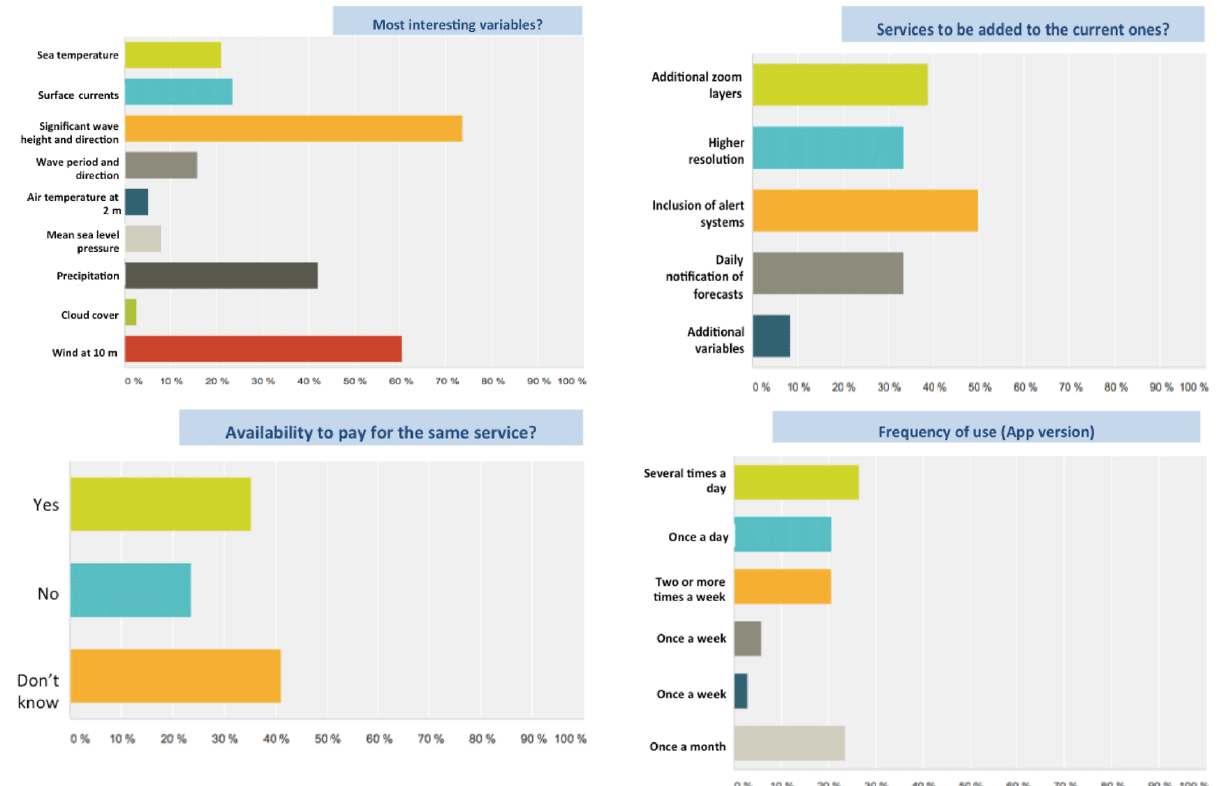
Figure 11. Selected questions and answers by users from SeaConditions online